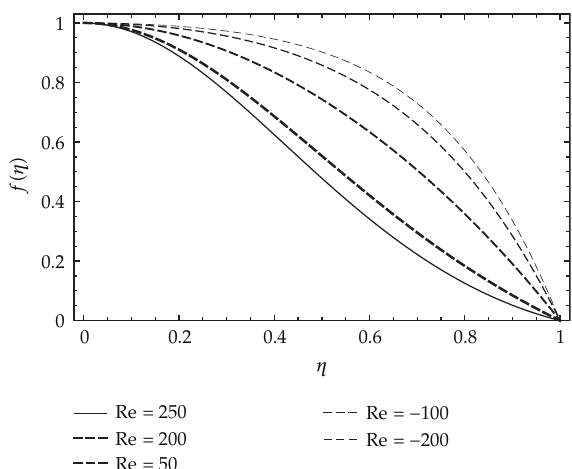
Figure 8: DTM solution for velocity in divergent channel for α (cid:8) 2 . 5 ◦ and H (cid:8) 1500.